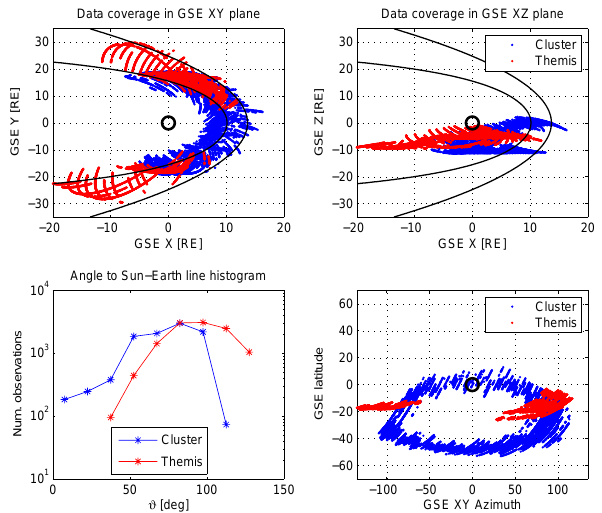
Fig. 5. Coverage of the magnetosheath by Cluster and THEMIS test datasets. The bottom left panel shows the histogram of data points binned in the zenith angle ϑ . The dataset contains a total of 23554 observations: 11403 from Cluster 1 and 12151 from THEMIS P1 (TH-B) and P2 (TH-C).